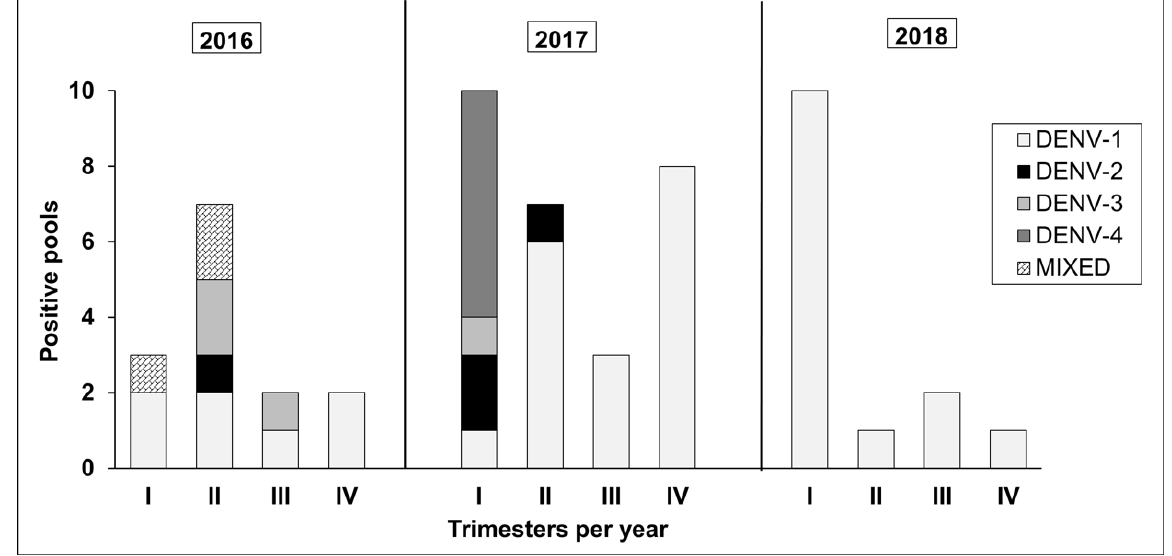
Figure 4. Distribution of dengue serotypes over time in Aedes spp. captured in schools inspected between 2016 and 2018 in Medellín, Colombia.